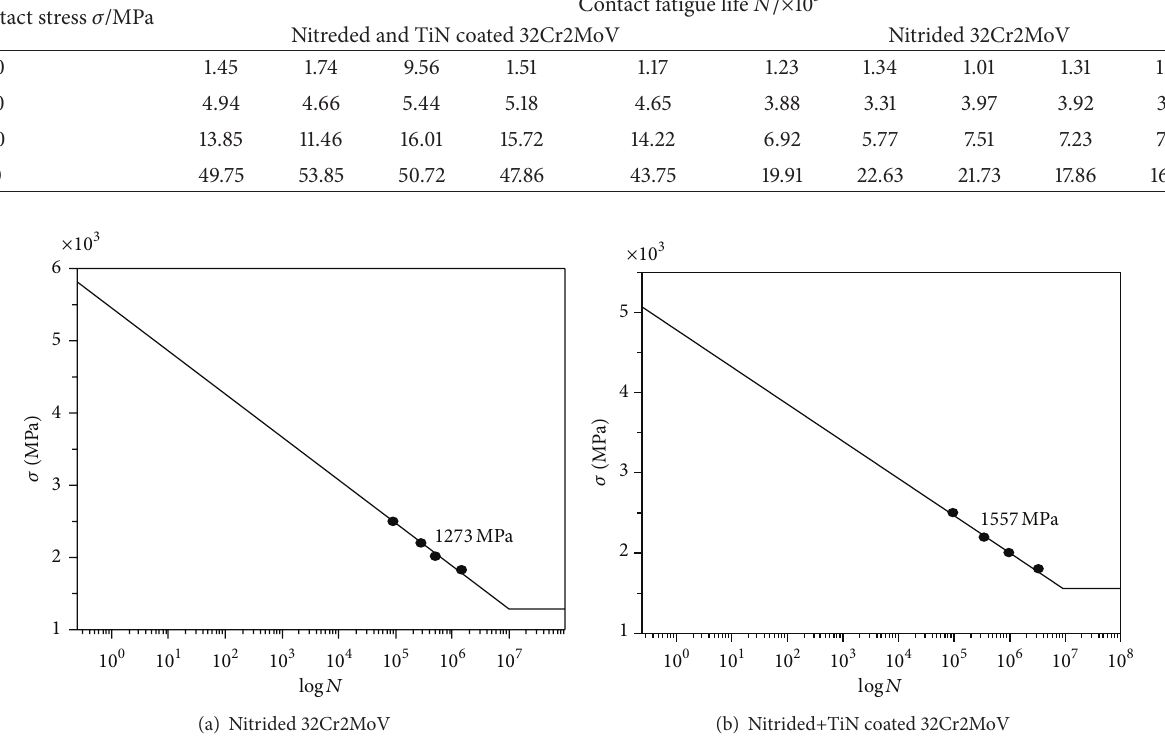
Figure 1: 99% survival probability P-S-N curves.